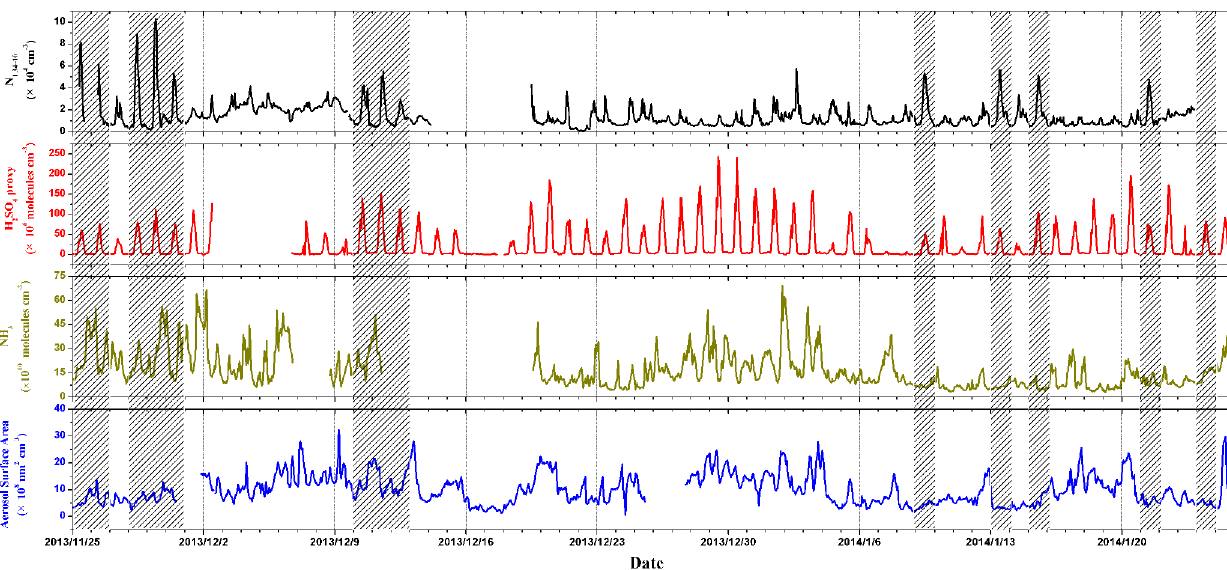
Figure 7. Number concentrations of 1.34–10nm particles ( N 1 . 34 ∼ 10 ) , sulfuric acid proxy ( [ H 2 SO 4 ] ), concentrations of ammonia, and aerosol surface area during the campaign. NPF events are illustrated with